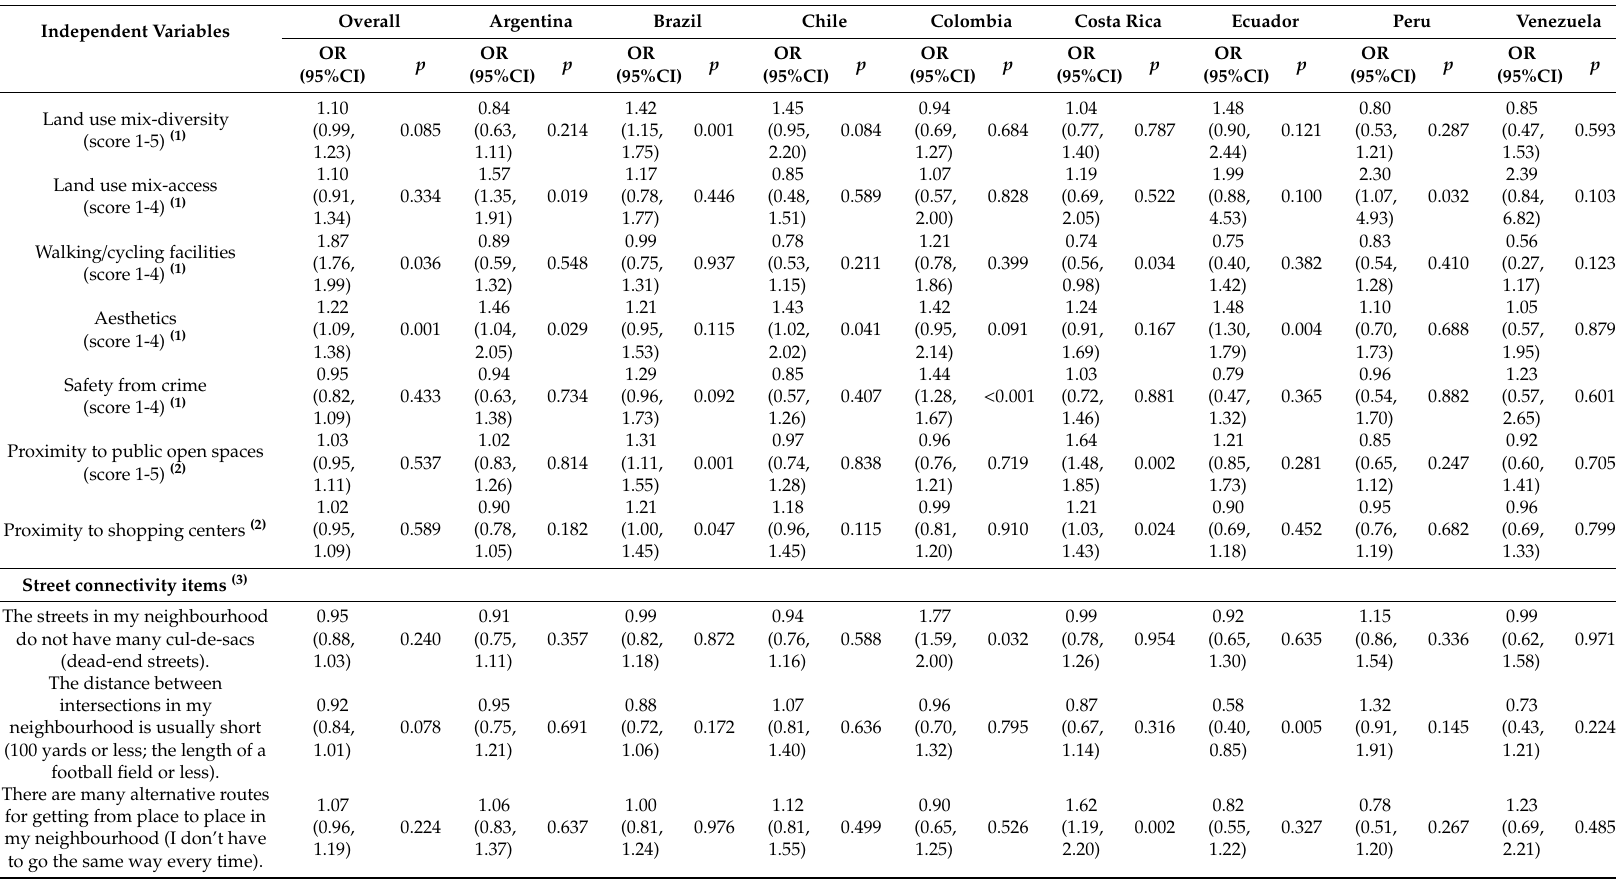
Table 5. Multilevel logistic regression models (OR (95%CI)) for cycling for transport (0: < 10 min / week, 1: ≥ 10 min / week) by country. Overall Argentina Brazil Chile Colombia Costa Rica Ecuador Peru Independent Variables